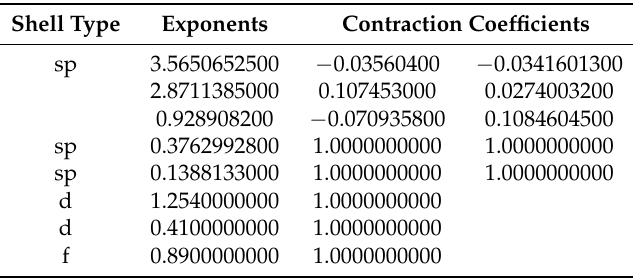
Table A15. Parameters of the cc-TZVP basis set of Argon.